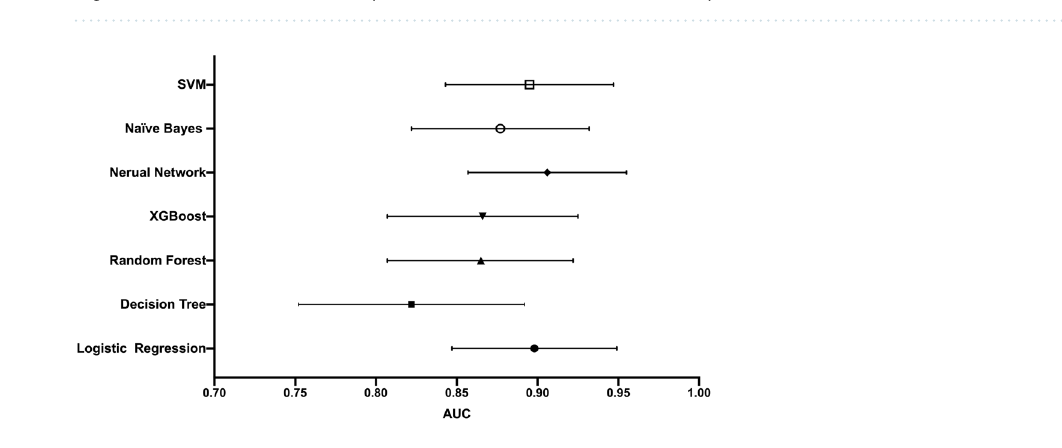
Figure 4. AUC of machine learning models predicting PICS-CI of testing